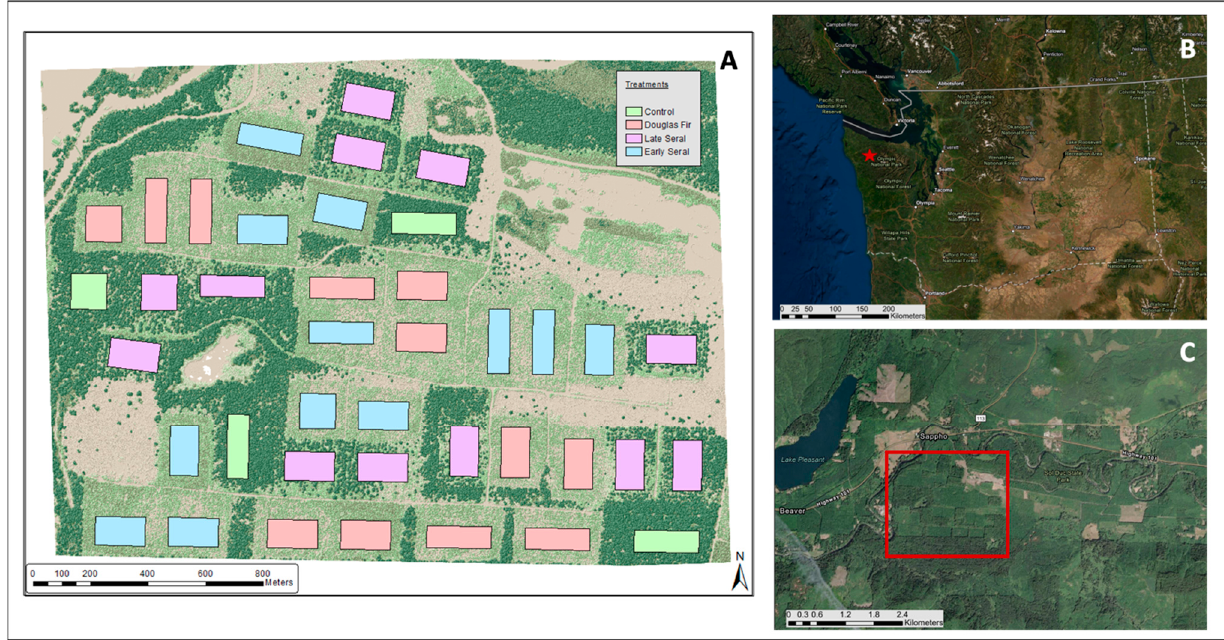
Figure 1. Map of Sappho Long-term Ecosystem Productivity site ( A ) with the locations of experi- mental units indicated by rectangles. Only the early seral units (blue) were included in this analysis. Location of Sappho site in larger context of the state of Washington, USA, with Sappho site indicated with a red star ( B ). Overview of the Sappho site with Sappho site indicated by a red rectangle ( C ).